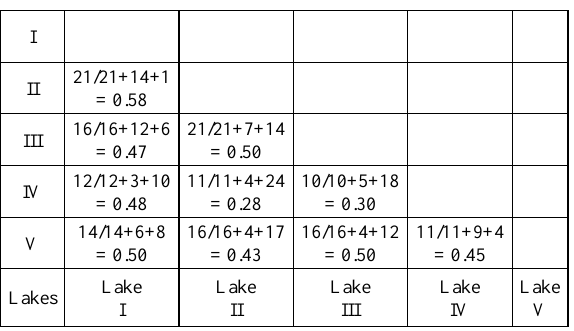
Table 6. Use of Jaccard’s coefficient to find similarity, %